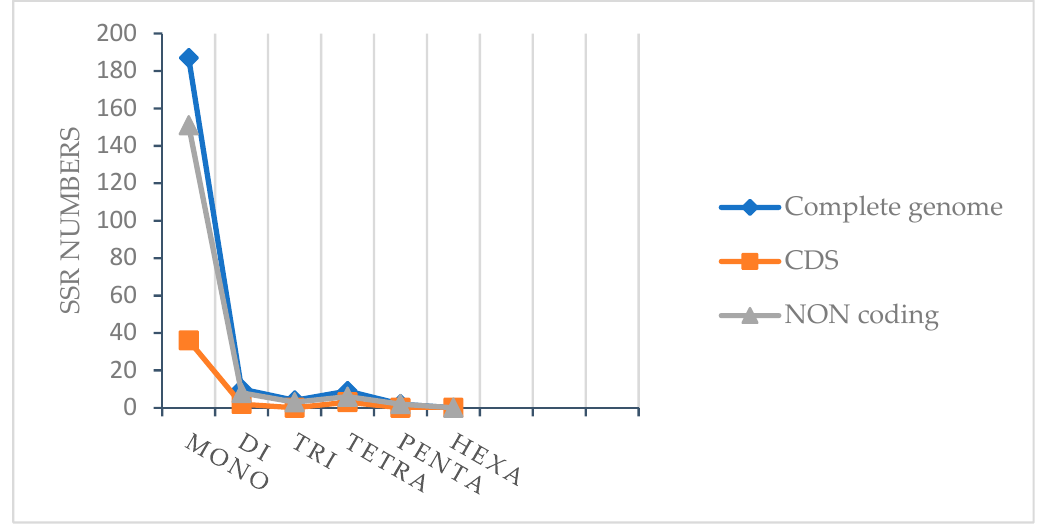
Figure 5. Number of SSR types in the complete cp genome, and protein-coding and non-coding sequences in A. fruticosum . The rate of occurrence of SSRs among the plastomes of the five species of Malvaceae was compared (Figure 6); the comparison indicates a high number of mononucleotides across all the plastomes. E. attenuatus and A. paniculata had the highest number of mononu- cleotides with 107 and 104, respectively. Pentanucleotides were not found in the plastome of B. prionitis , E. attenuatus , A. knappiae, B. ciliaris and R. breedlovei , while hexanucleotides were only present in B. prionitis, R. breedlovei and A.